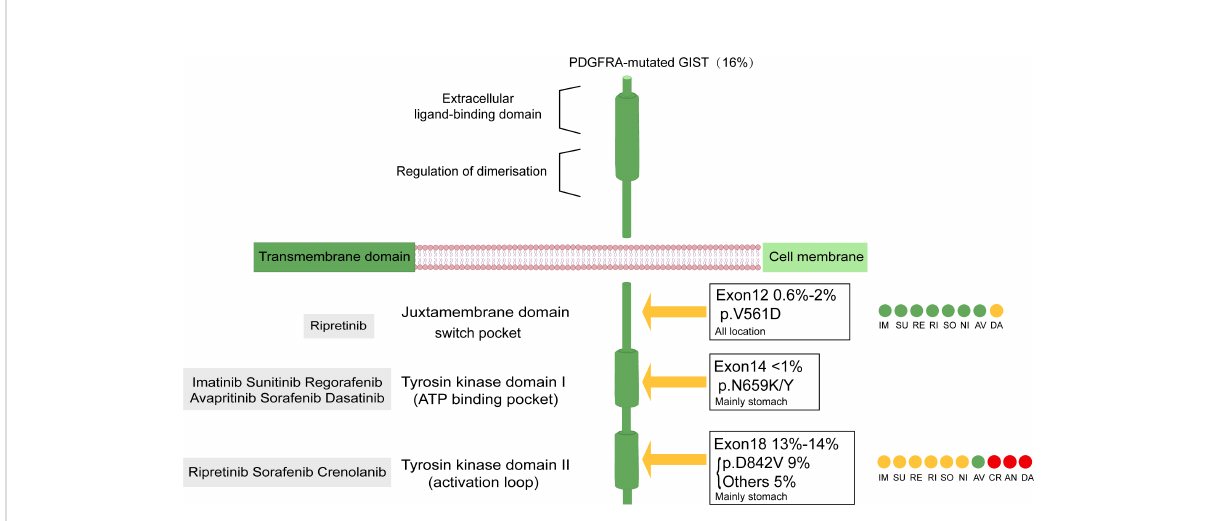
FIGURE 1 Structure of PDGFRA transmembrane tyrosine kinase receptor. Graphical representation of PDGFRA transmembrane tyrosine kinase receptors with frequency and localization of mutations found in advanced GIST. Gray boxes represent the site of action of the drug. Drug sensitivity of primary and secondary mutations in PDGFRA-mutated GISTs was distinguished by color: green indicates sensitive, yellow indicates mainly sensitive, red indicates in vitro test proved to be valid, but the clinical trial still had no de fi nite result.CR Clinical trials in PDGFRA D842V population still ongoing; DA AN in vitro trial Valid but no clinical trial; NI speci fi cally involving PDGFRA in vitro demonstrated activity against exon 12, diminished activity against D842V. AV, avapritinib; IM, imatinib; RE, regorafenib; RI, ripretinib; SU, sunitinib: SO, sorafenib; CR, crenolanib, DA, dasatinib; Ni, nilotinib; AN,